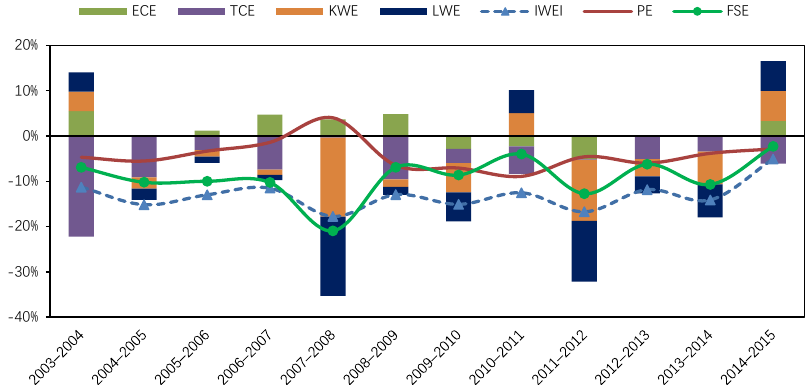
Figure B7. Driving factors of industrial wastewater emission intensity change in the Southwest Area, 2003 – 2015. ECE: the effect of technical efficiency change; TCE: the effect of technological change; KWE: the effect of capital – wastewater substitution; LWE: the effect of labor – wastewater substitution; IWEI: industrial wastewater emission intensity; PE: productivity effect; FSE: factor substitution effect.